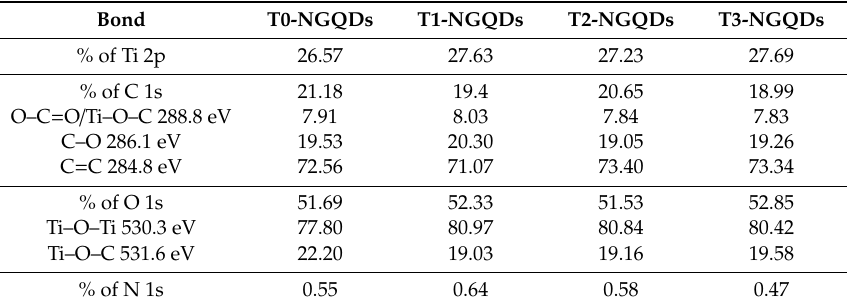
Table 2. Percentages of di ff erent bonds according to the fitting results of the XPS high-resolution spectra calculated from Figure